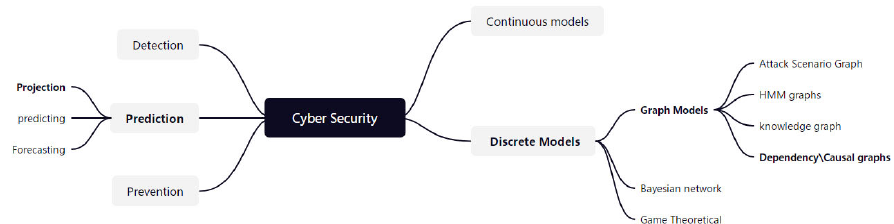
Figure 1. Cybersecurity use case profiling.